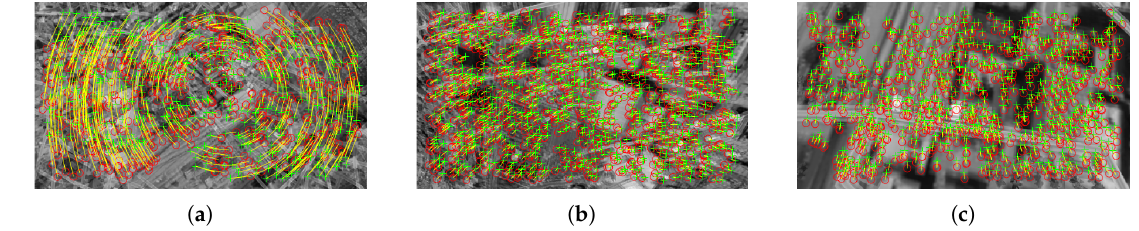
Figure 4. SURF keypoints from Figure 3 after removing faulty matching for: ( a ) spinning phase, ( b ) diving phase, ( c ) recovery